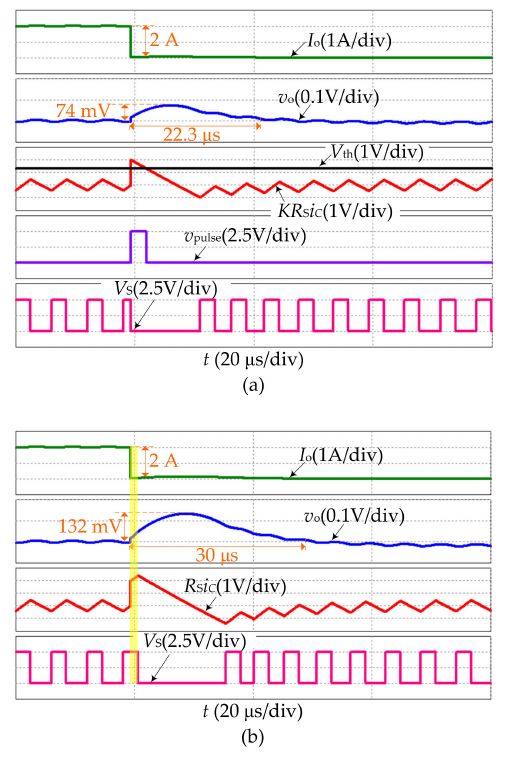
Figure 9. Simulation waveforms for the buck converter with improved CC-COT control and the CC-COT control when the load step-down occurs during the on-time interval: ( a ) the improved CC-COT control and ( b ) the CC-COT